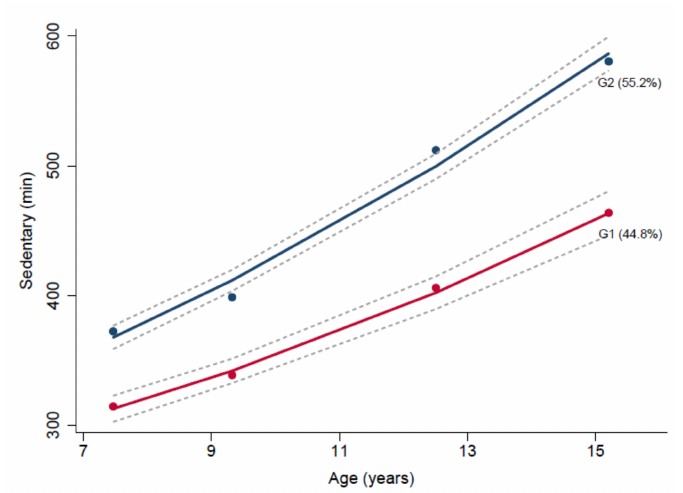
Figure 2. Group based trajectories of time spent in sedentary behaviour. Dots indicate average sedentary behaviour (minutes/day), and two black lines are trajectories showing estimated mean time spent in sedentary behaviour (minutes/day) across age for the two groups identified (G1–G2), and grey dashed lines represent the 95% confidence intervals for each